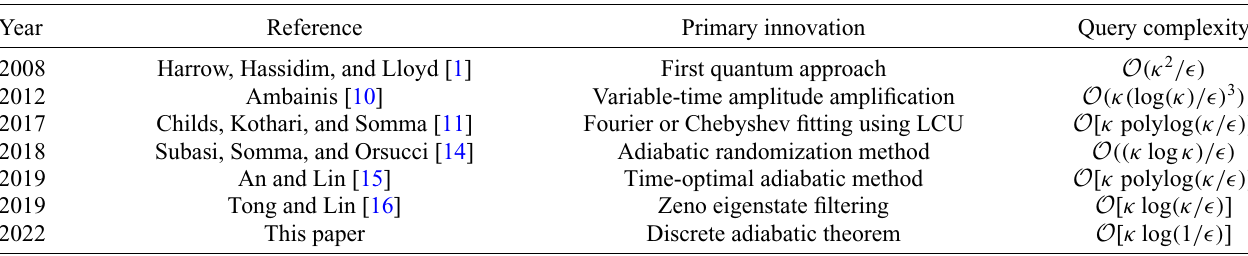
TABLE I. The history of the lowest-scaling algorithms for solving linear systems of equations on a quantum computer. Specifically, the problem is to prepare the state | x (cid:2) given oracular access to the matrix A and the ability to prepare the initial state | b (cid:2) encoding a vector b with the relation Ax = b . Here, κ is the condition number of A and (cid:3) is the target precision to which we would like to prepare the state | x (cid:2) . However, the cost of a query for all classical algorithms is expected to scale polynomially in N (the dimension of the matrix A ), whereas on a quantum computer it is possible to make queries in complexity scaling as O [polylog ( N ) ] when A is a sparse matrix. The query complexity of (cid:4) [ κ log ( 1 /(cid:3)) ] is a known lower bound on the complexity.